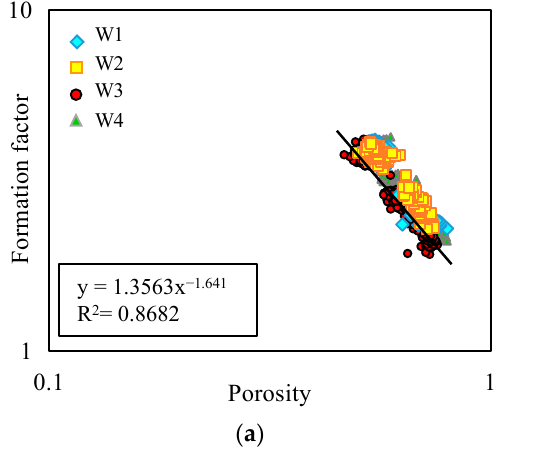
Figure 7. Rock–electricity relationships in the study area. ( a ) Relationship between formation factors and porosity. ( b ) Relation between resistivity index and water saturation.